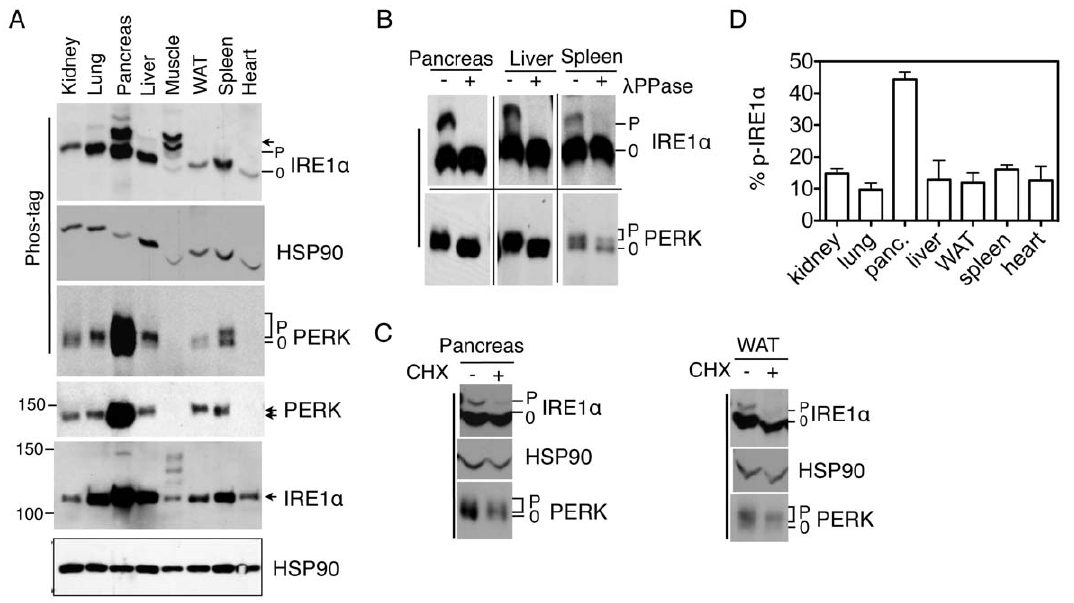
Figure 3. Many tissues exhibit basal ER stress under feeding conditions. (A) Immunoblots of IRE1 a and PERK in various tissues of wildtype mice. WAT, white adipose tissues; Panc, pancreas; Muscle, gastrocnemius. HSP90, a position and loading control. ( B–C ) Immunoblots of IRE1 a and PERK in tissue lysates treated with l PPase ( B ) or in pancreatic and WAT lysates prepared from mice injected with CHX ( C ). ( D ) Quantitation of percent of phosphorylated IRE1 a in total IRE1 a protein in various tissues shown in A. Values are mean 6 SEM. Representatives of at least two independent experiments shown.